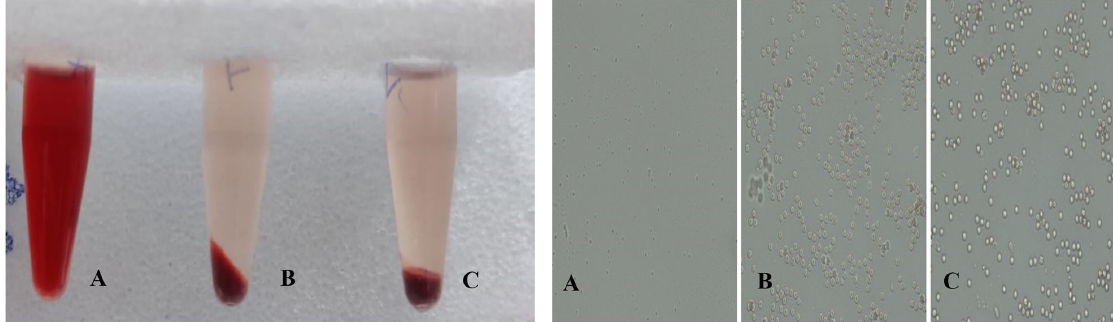
Figure 8. Results obtained from haemolysis studies of RBCs treated with ( A ) positive control (Triton X ‐ 100); ( B ) negative control (0.9% w/v NaCl) and ( C ) NEB ‐ loaded dual ‐ responsive in situ gel.